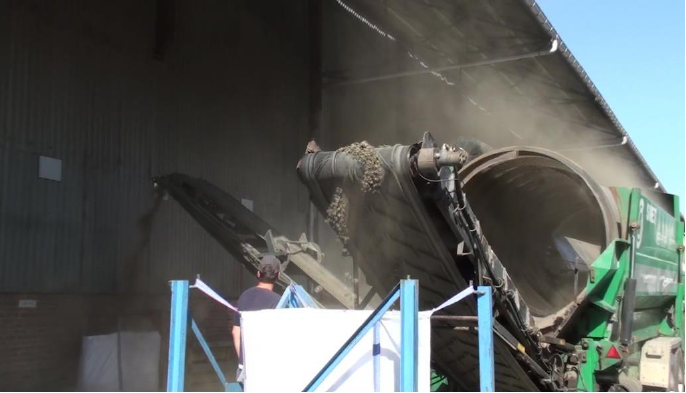
Figure 12. Step of rotating drum sieving.